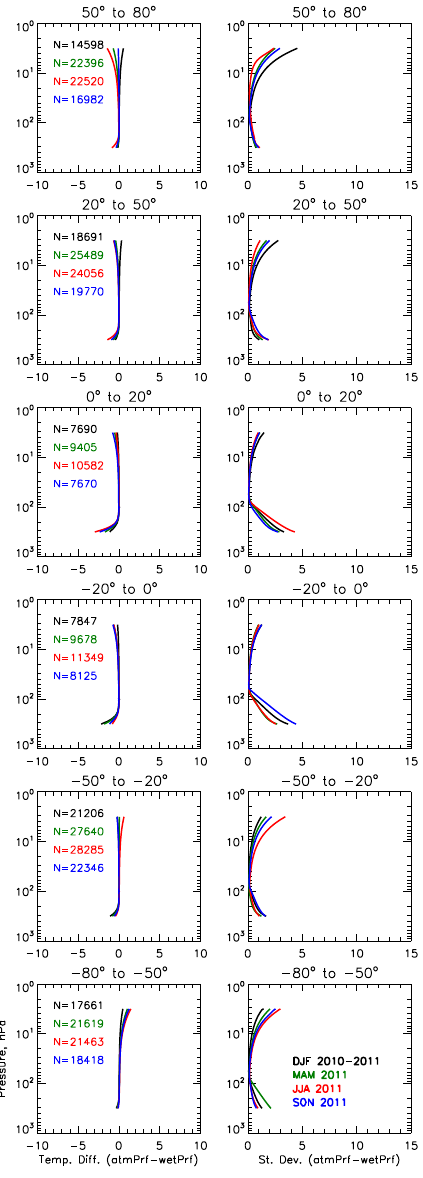
Fig. 3. Seasonal median differences between “atmPrf” & “wetPrf” temperatures obtained from simultaneous retrievals (column 1) and the corresponding standard deviations (column 2) in different lati- tudinal regions (rows) and during different seasons (profile